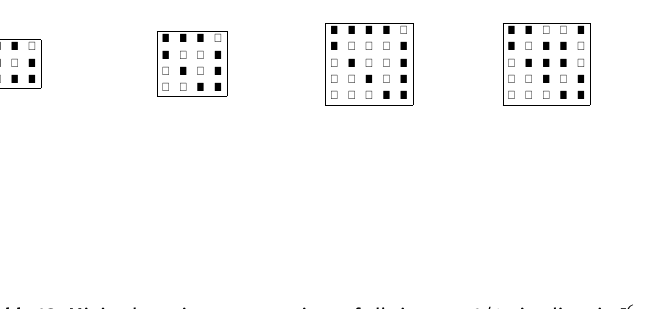
Table 17: Minimal matrix representations of all acute 0/1 -simplices in I 3 , I 4 and I 5 .